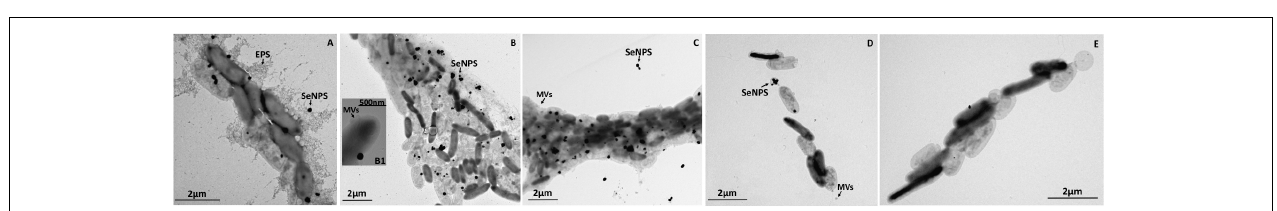
FIGURE 2 | Time course imaging by transmission electron microscopy (TEM) of Stenotrophomonas maltophilia SeITE02 strain grown in DM amended with glucose (0.5% v/v) and SeO 2 −